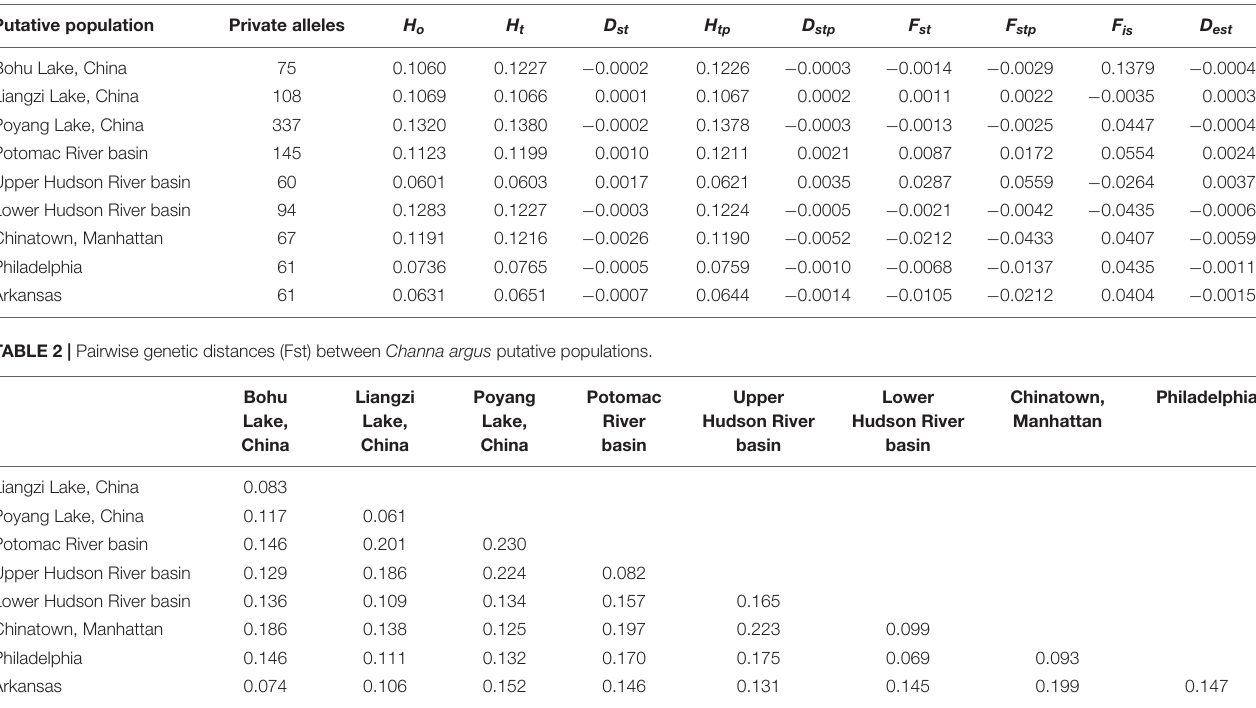
FIGURE 4 | Admixture for C. argus populations ( k = 6) in the United States when compared to three native range populations from central China. TABLE 1 | Summary statistics for single nucleotide polymorphism locus variation at each collection site.